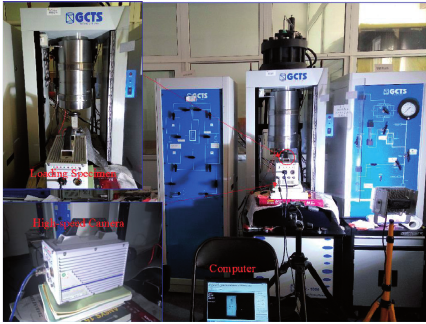
Figure 3: Testing process and main equipment used